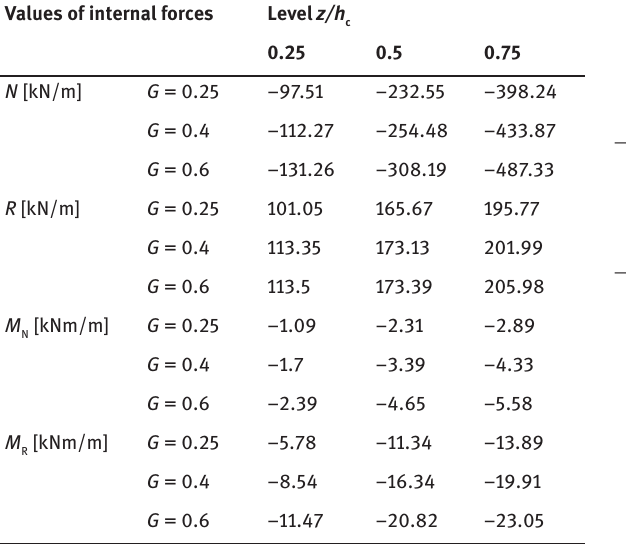
Table 6: Extreme values of internal forces in the wall of the silo with the diameter d =10 m emptied on a large eccentric taking into c account the occurrence of non-centric flow channel .